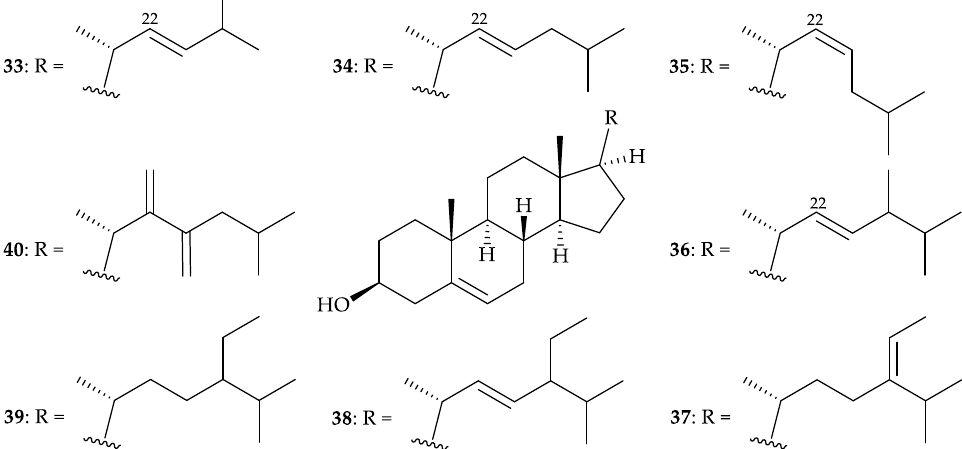
Figure 7. Structures of 26,27-dinorergosta-5,22-dien-3 β -ol ( 33 ), cholesta-5,22-dien-3 β -ol (including 22- trans form 34 and 22- cis form 35 ), ergosta-5,22-dien-3 β -ol ( 36 ), stigmasta-5,24-dien-3 β -ol ( = fucosterol) ( 37 ), stigmasta-5,22-dien-3 β -ol ( 38 ), stigmasta-5-en-3 β -ol ( 39 ), and 22,23-methylene- cholesterol ( 40 ).